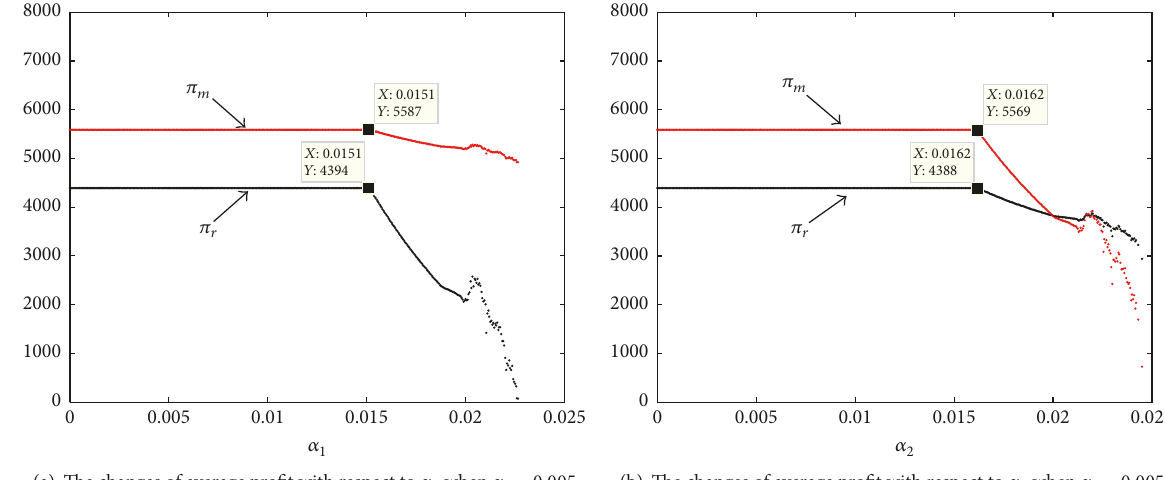
Figure 8: The change of average profit with respect to 𝛼 1 and 𝛼 2 .